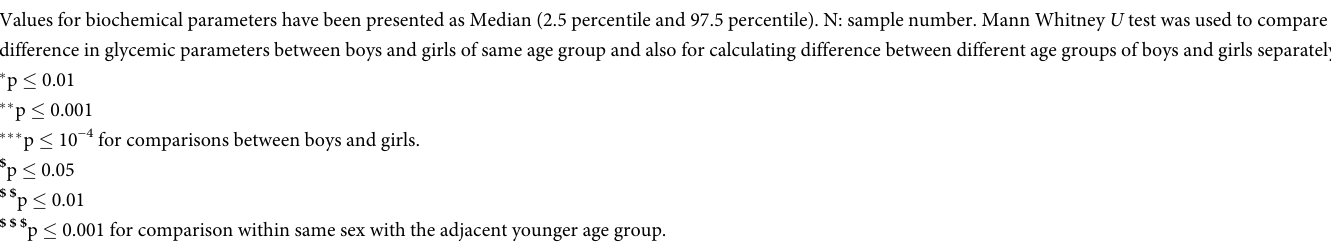
Values for biochemical parameters have been presented as Median (2.5 percentile and 97.5 percentile). N: sample number. Mann Whitney U test was used to compare difference in glycemic parameters between boys and girls of same age group and also for calculating difference between different age groups of boys and girls separately.